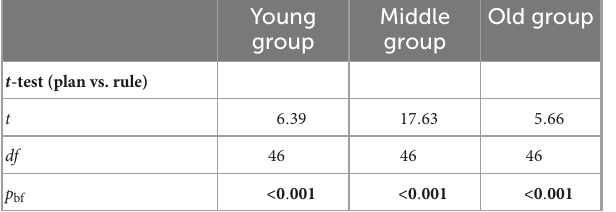
Table shows descriptive statistics for reaction times (RT) and drift diffusion model (DDM) parameters per task and age group, as well as inferential statistics showing within-subjects comparisonofRTandDDMparametersforplan-versusrule-tasks(median, Mdn ;mean, M ; SD, standarddeviation;s,seconds;ms,milliseconds; p bf ,Bonferronicorrected p -value).Bold fontdenotes p -values <